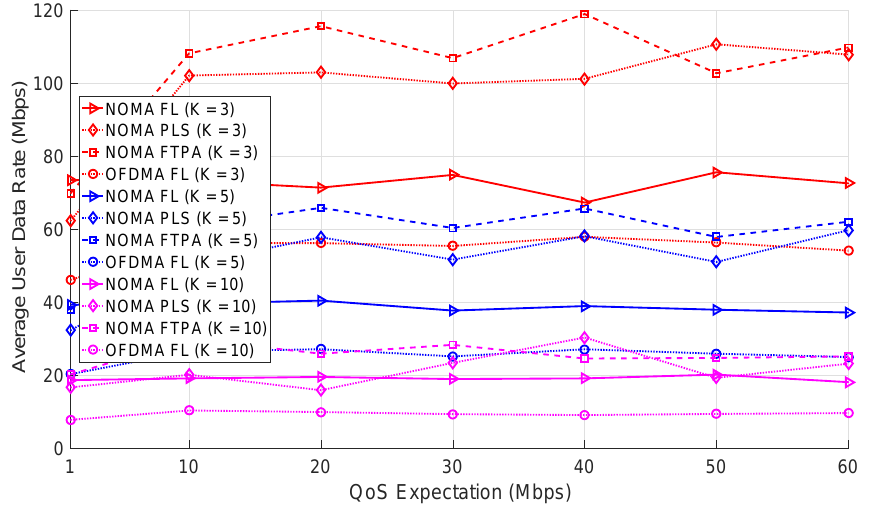
Figure 7. Comparisons of AUDR with varied QoS expectations and number of